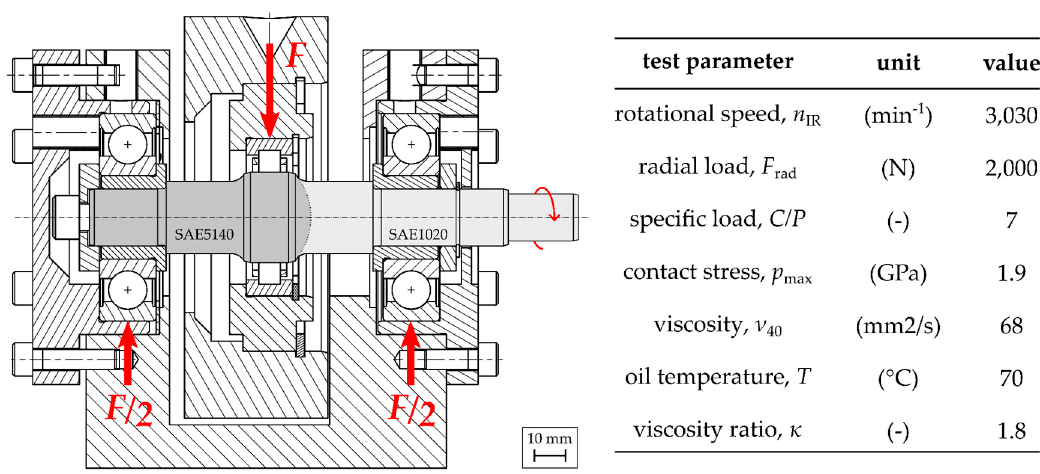
Figure 3. Fatigue life test in three ‐ bearing arrangement ( left ), and test parameters ( right ).